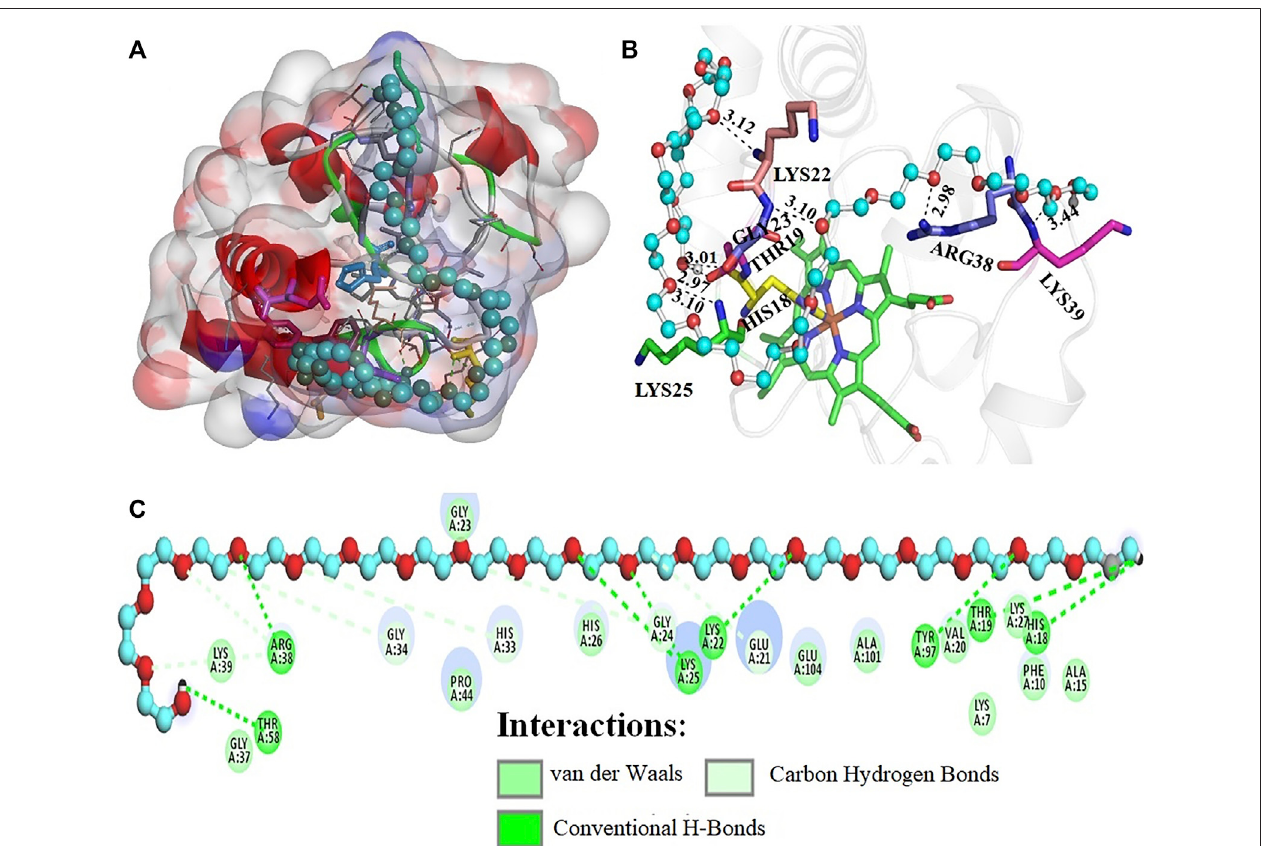
FIGURE8|(A) Surfaceareaandbindingsiteonthecyt c (cartoonmodel,red)forPEG20(ballandstickmodel,blue). (B) Variousaminoacidresidues(stickmodel) of the protein interacting with PEG 20 (ball and stick model, blue) with given bond lengths. (C) 2D representation of various types of interactions of amino acid residues with PEG